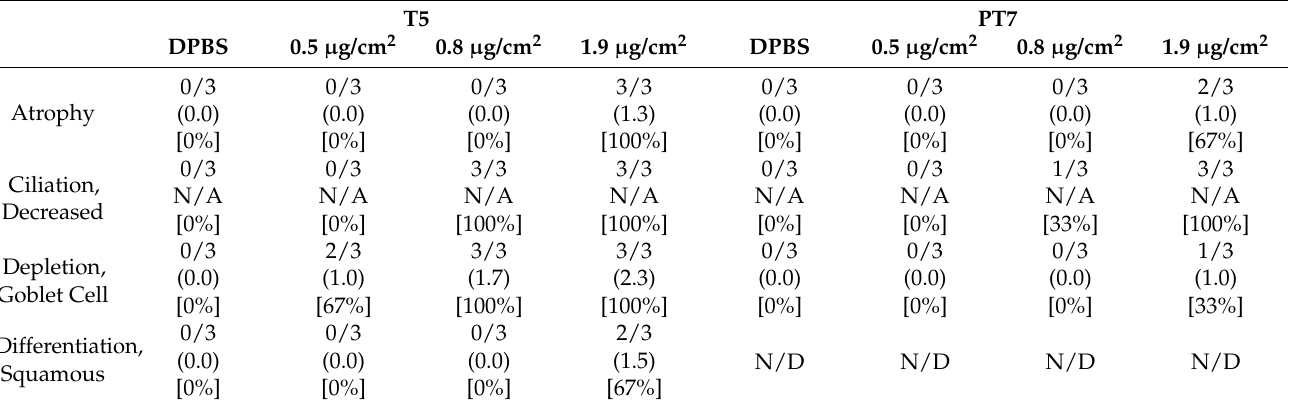
Table 2. Morphological changes in GA-exposed ALI cultures at T5 and